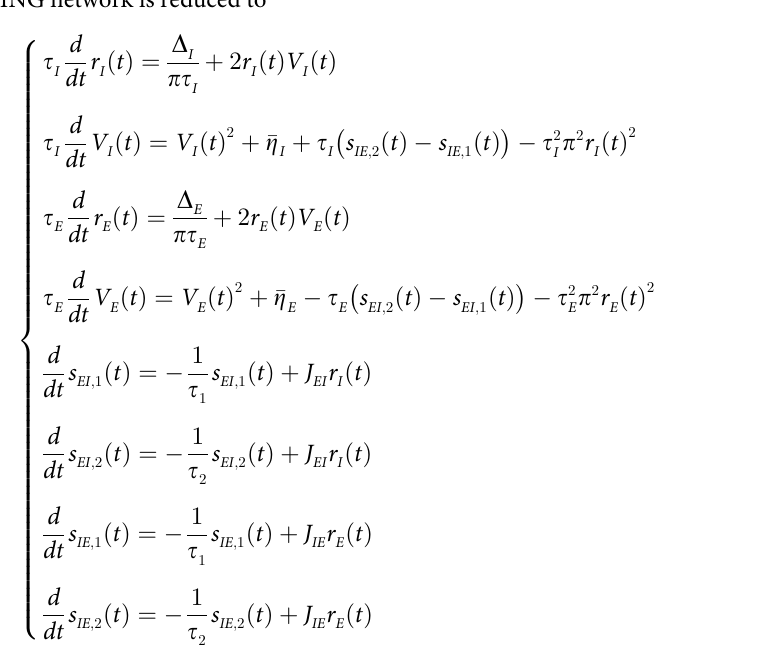
S2 Fig. fmPRC of heterogeneous ING networks for fixed steady current ( I ( I ) = 15.8 pA) instead of fixed frequency (cf. Fig 2A). The paradoxical phase advance increased with